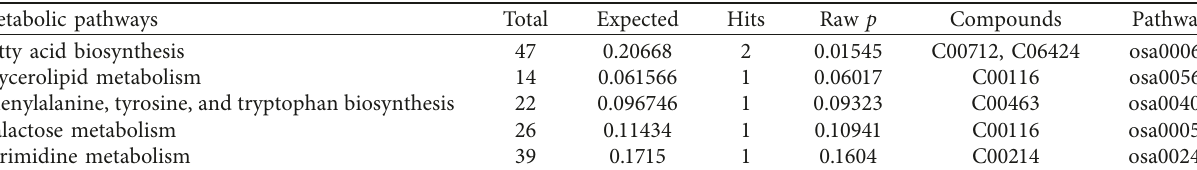
Figure 5: The hierarchical cluster diagram of differential Table 3: Metabolic pathways of the differential metabolites.